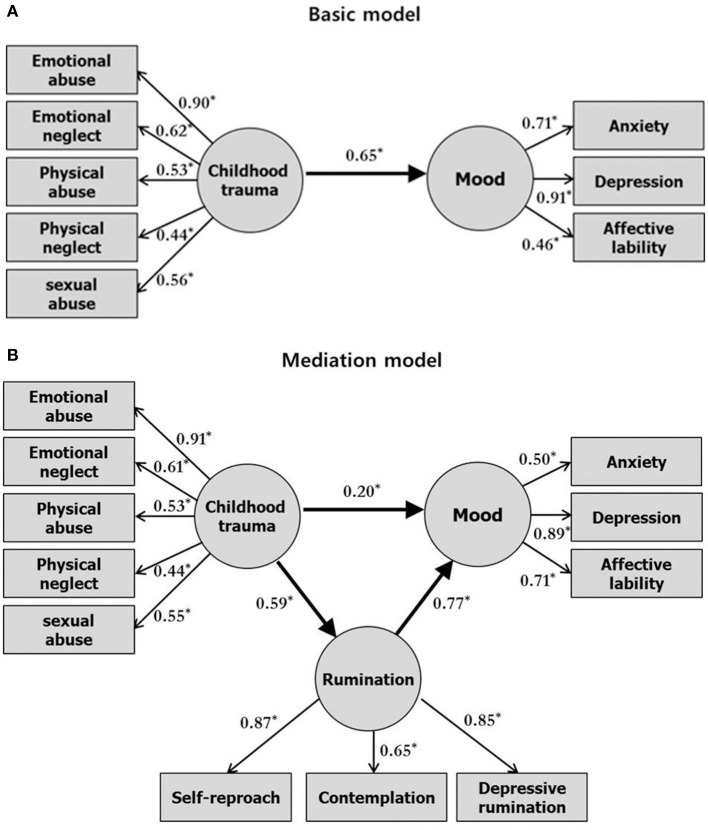
Basic model of the relationship between childhood trauma and mood (A), and mediation model showing rumination as a mediator of the relationship (B) in female participants. Rectangles represent observed variables. Circles represent latent variables. Numbers on single-headed arrows indicate standardized regression weights. *p < 0.05, multiple regression analysis.